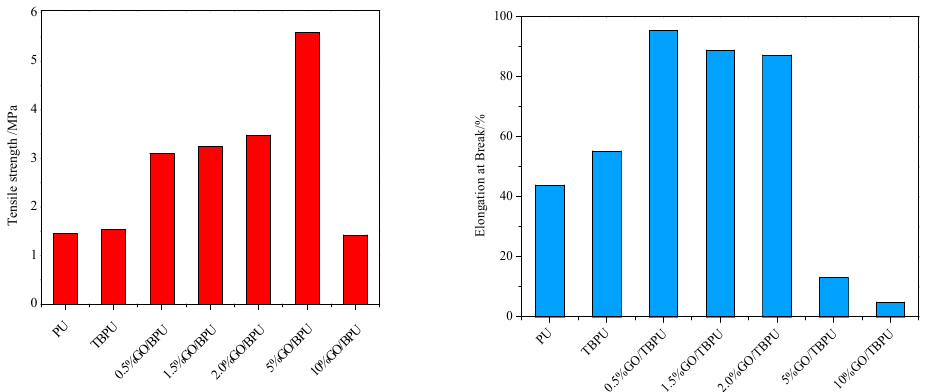
Figure 6. Tensile strength (left) and elongation at break (right) of PU, TBPU, and GO-TBPU.